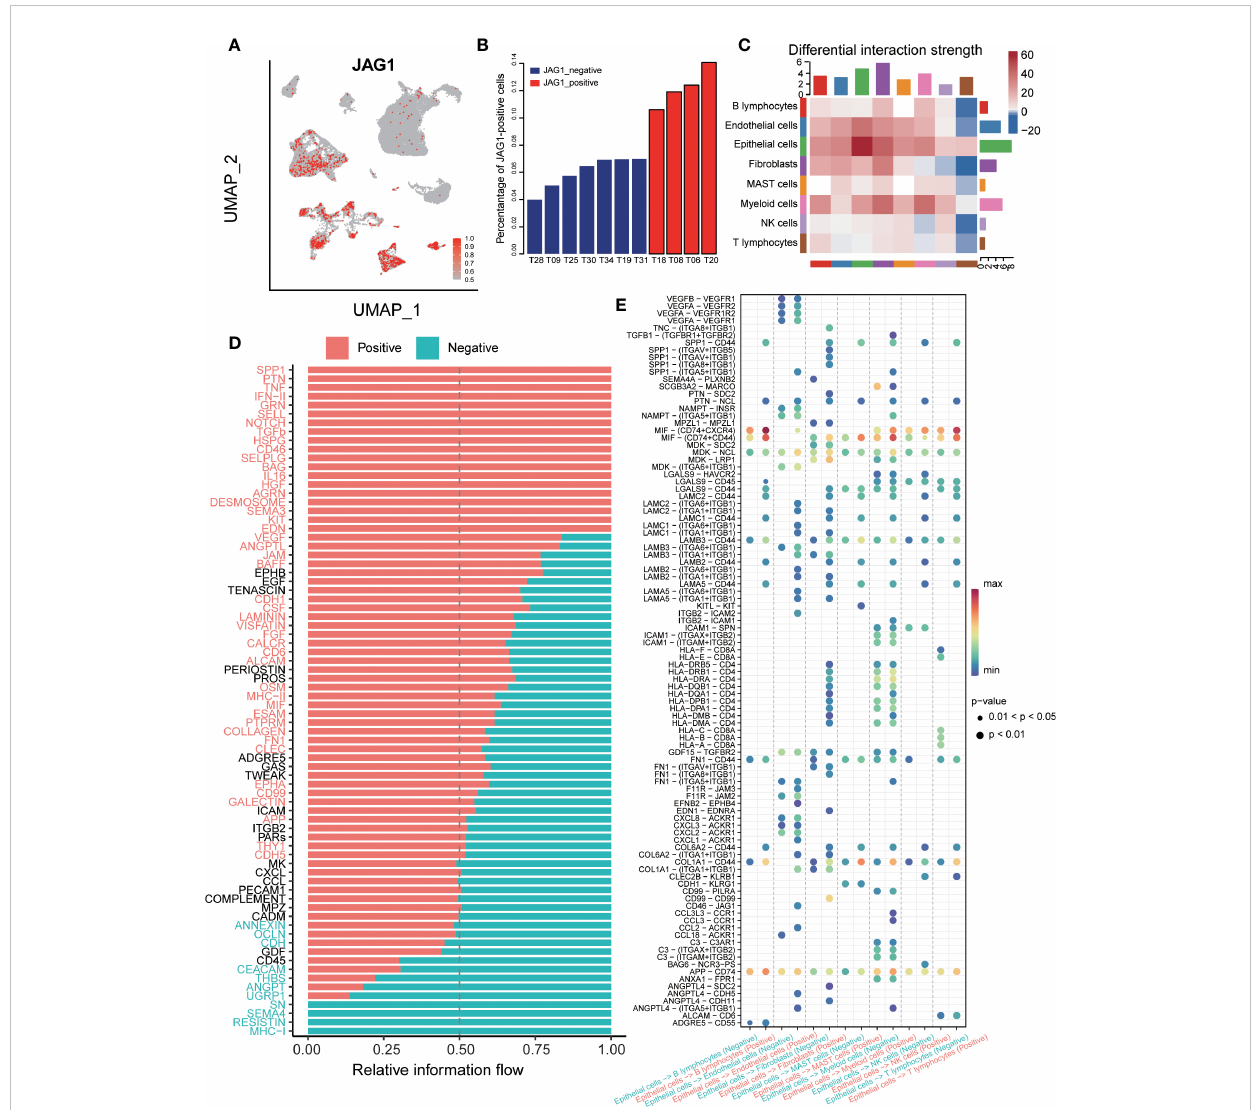
FIGURE 7 The cell-cell communication between JAG1 positive and negative samples. (A) The TSNE clustering visualization of JAG1 expression. (B) Histogram showed the composition of positive cell among 11 samples, ordered by percentage of JAG1 + cells. (C) The differential interaction strength of JAG1 positive and negative samples. Red represents stronger interaction in the JAG1 positive group, Blue represents stronger interaction in the JAG1 negative group. (D) Signi fi cantly activated signal fl ow between JAG1 positive and negative samples. (E) Dot plot showed signi fi cantly different ligand- receptor interaction between two